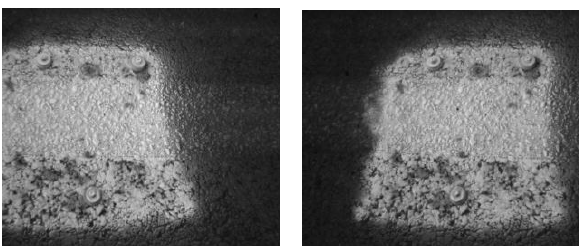
Figure 7. Stereo pair of the road with reference